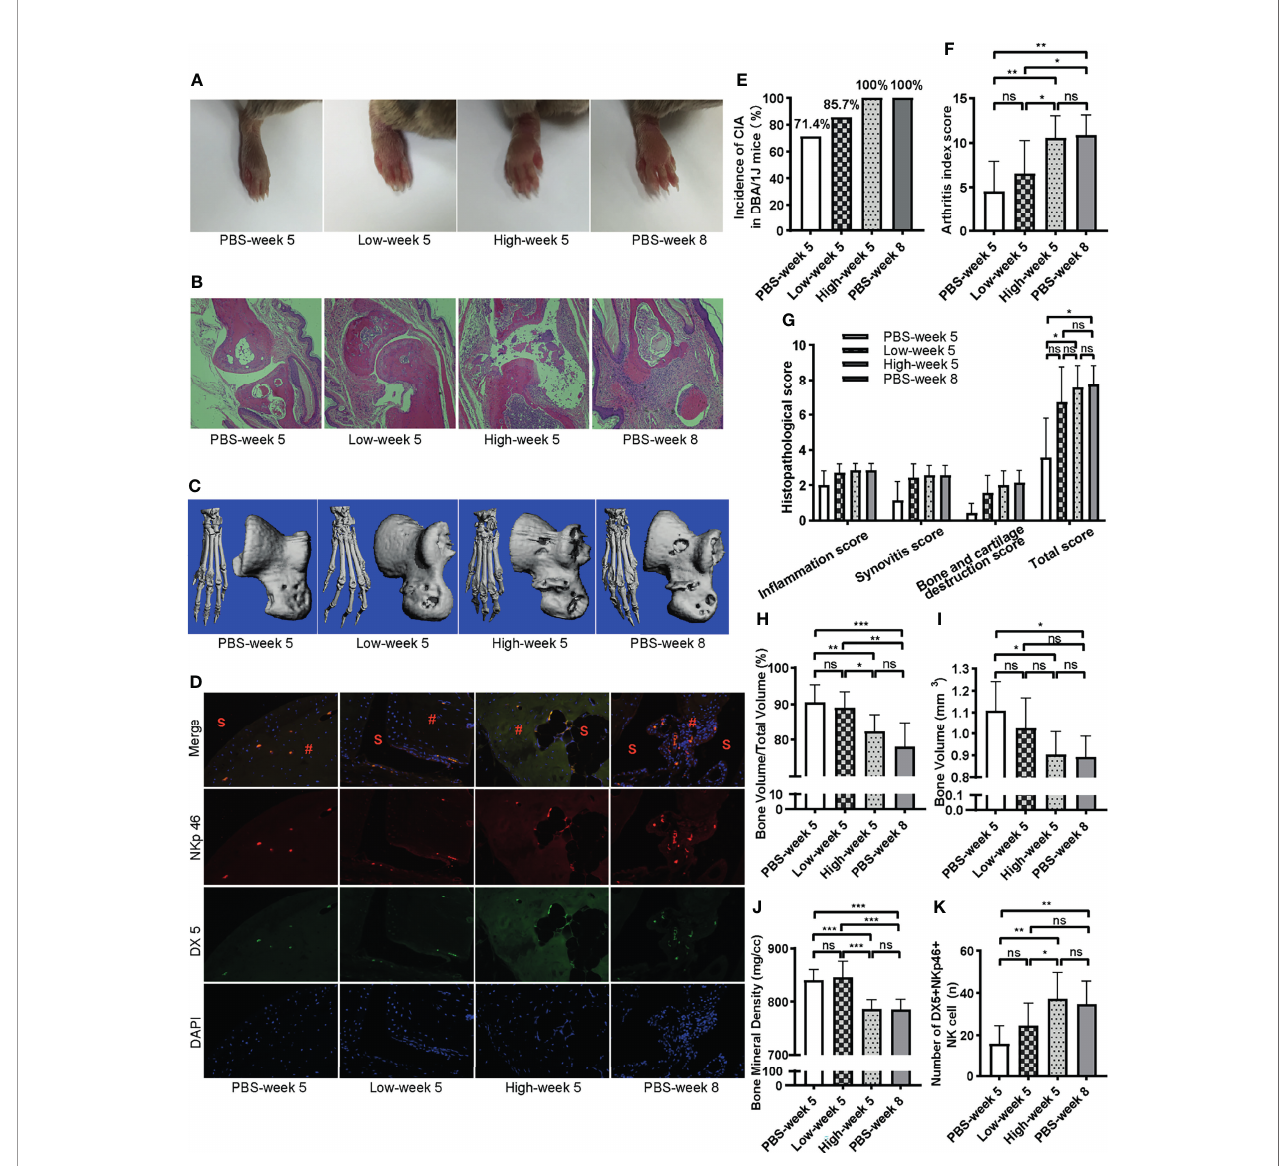
FIGURE 5 | Adoptive transfer of NKp46 + NK cells exacerbates arthritis. (A) Representative images of hind paws showing mild, moderate, and severe, severe swelling (from left to right). (B) Representative histological staining (H&E, ×100 magni fi cation). (C) Reconstructed micro-CT 3D models of claw and talus. (D) Representative images of immuno fl uorescence examination of NKp46 + NK cells in hind joints. S, synovial space; #, synovial tissue. (E – K) Incidence of arthritis, arthritis index score, histopathological score, bone volume, bone volume to total volume, bone mineral density, number of DX5 + NKp46 + cells among different groups, respectively. ANOVA with post-hoc LSD test for (F, H, J, K) , *p < 0.05, **p < 0.01, ***p < 0.001, ns, not signi fi cant. Kruskall – Wallis test for (G, I) , *p < 0.05, ns, not signi fi cant after adjusted by the Bonferroni correction. n = 7 per group. Results are representative of three independent